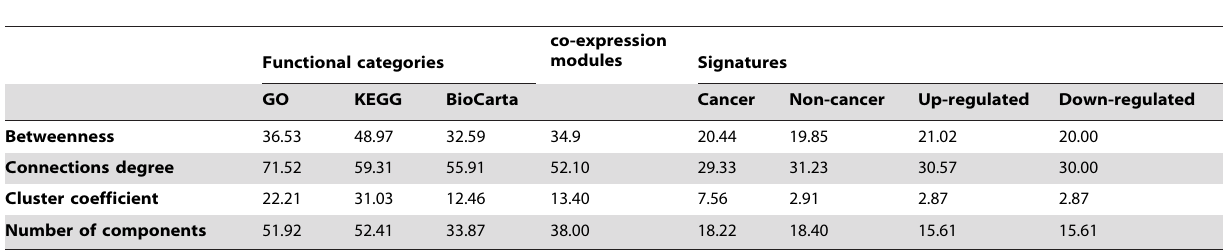
Table 3. Percentage of significant (p , 0.05) network parameters in the different module